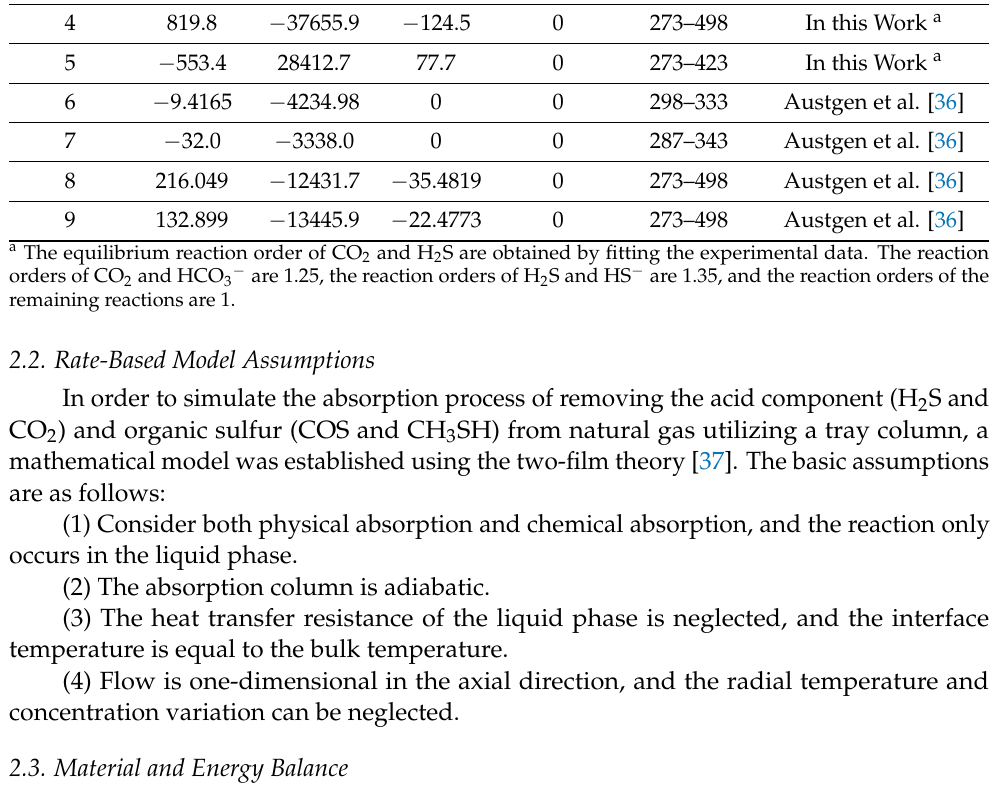
Table 2. Parameters for temperature-dependent mole-fraction reaction equilibrium constants.